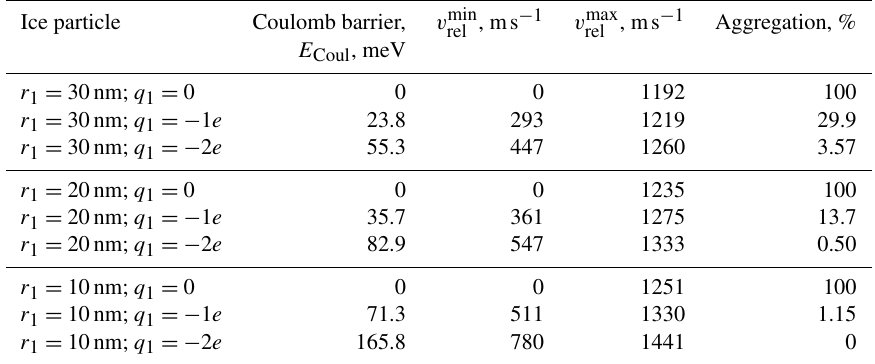
Table 2. Energetic considerations and the percentage of aggregation for SiO 2 –ice collisions at T = 150K and k r = 0 . 9 (the surface point charge model). The SiO 2 particle has a fixed radius and charge ( r 2 = 0 . 2nm, q 2 = − 1 e ), and the size and charge of ice particle is varied. The collision geometry is shown in Fig. 3a. The interactions of the MgO and FeO particles with ice show the same trend (see Tables A1 and A2 in the Appendix).